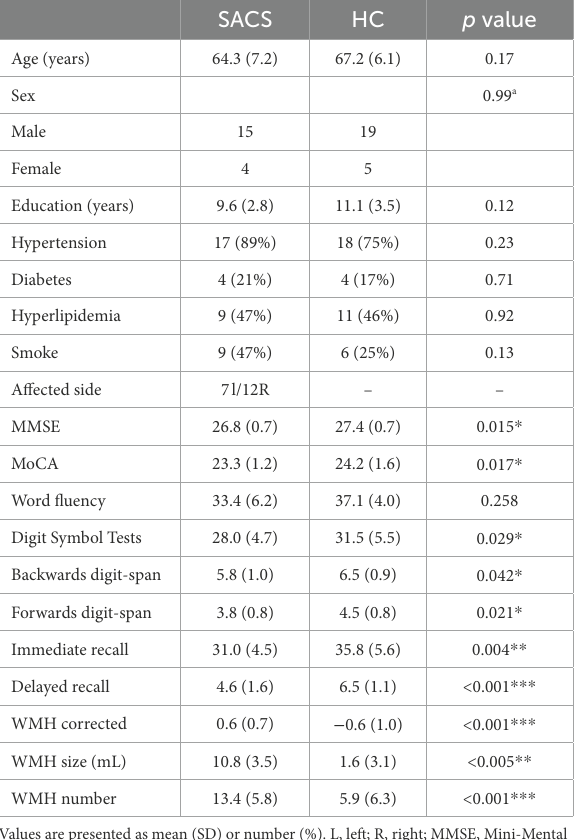
TABLE 1 Demographics and clinical